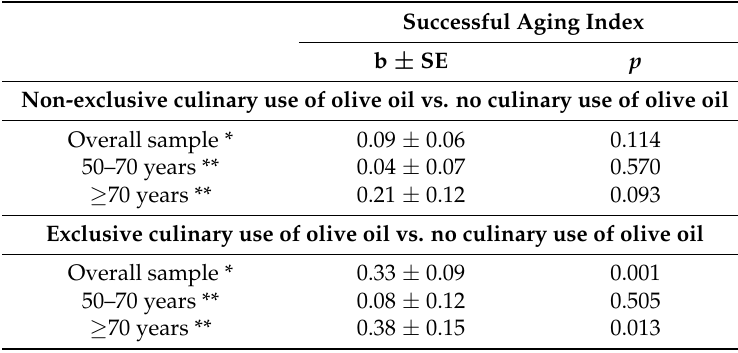
Table 3. Results from linear regression models (b ± SE) that evaluated the association between (a) “Non-exclusive culinary use of olive oil” category vs. “No culinary use of olive oil” category (independent variable) or (b) “Exclusive culinary use of olive oil” category vs. “No culinary use of olive oil” category (independent variable), and successful aging index (dependent